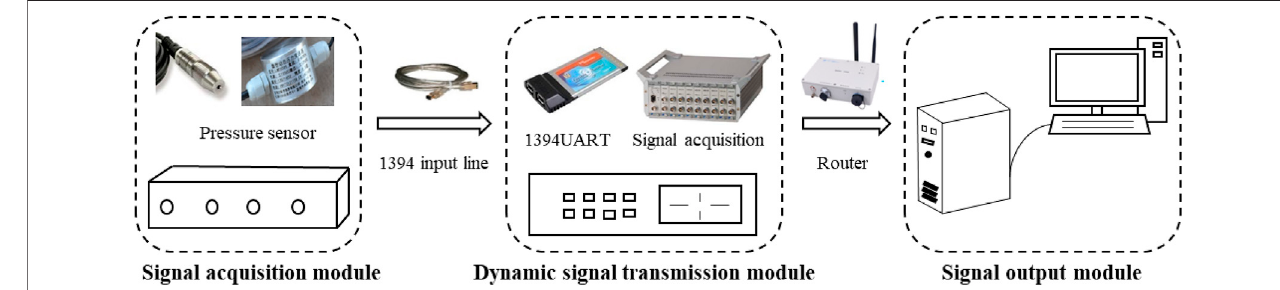
FIGURE 2 | In-situ test system of hydrodynamic pressure of pile.